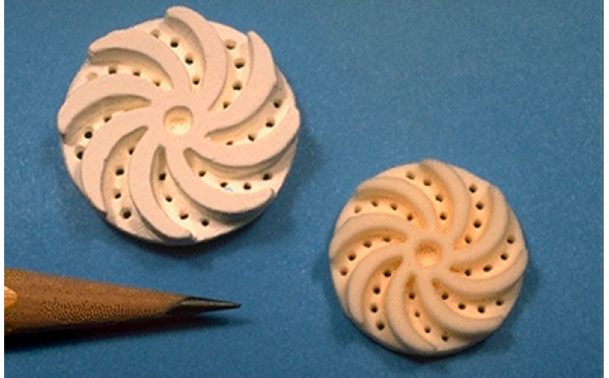
Figure 3. Structural alumina part before (left) and after (right) sintering with shrinkage [33] .